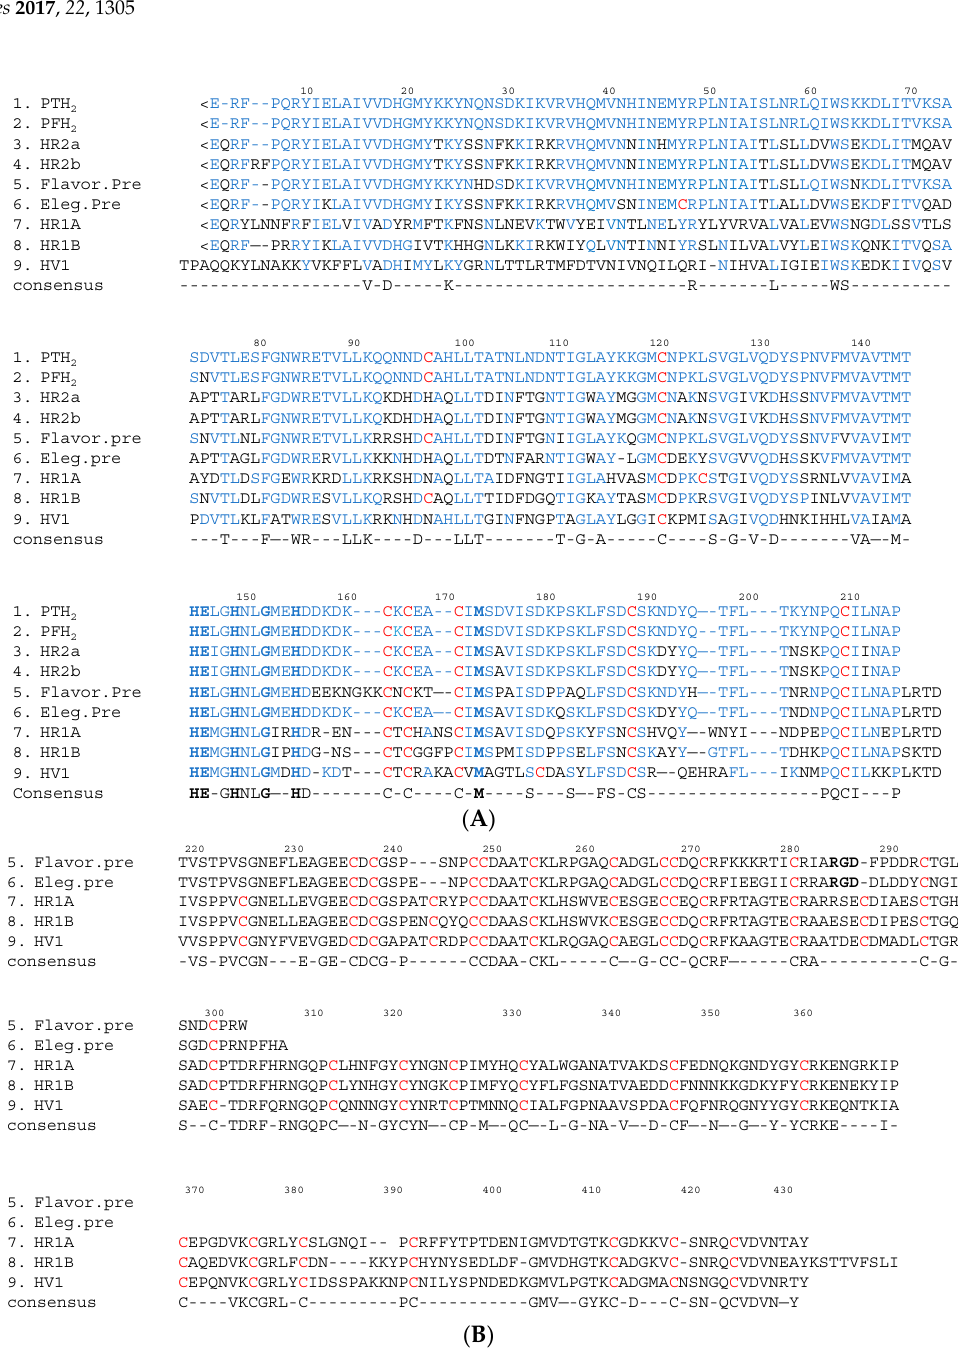
VVSPPVCGNYFVEVGEDCDCGAPATCRDPCCDAATCKLRQGAQCAEGLCCDQCRFKAAGTECRAATDECDMADLCTGR -VS-PVCGN---E-GE-CDCG-P------CCDAA-CKL-----C—-G-CC-QCRF—-----CRA----------C-G-